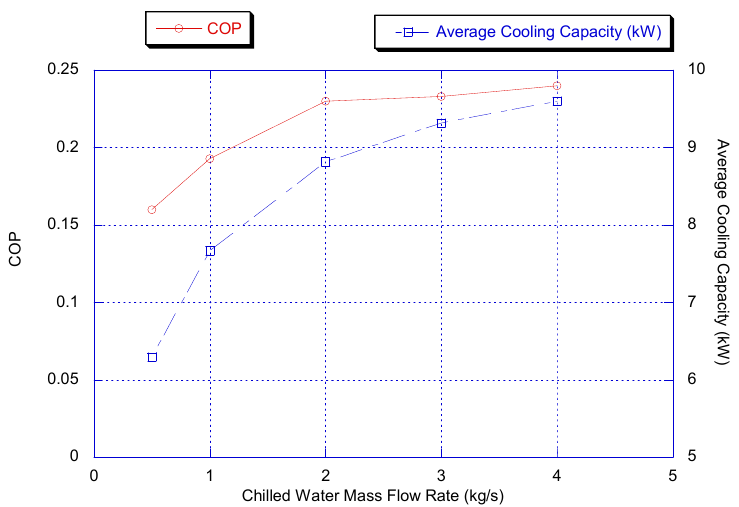
Figure 5. Effect of chiller flow rate on chiller average cooling capacity and COP (results are at chiller nominal operating conditions, shown in Appendix B).